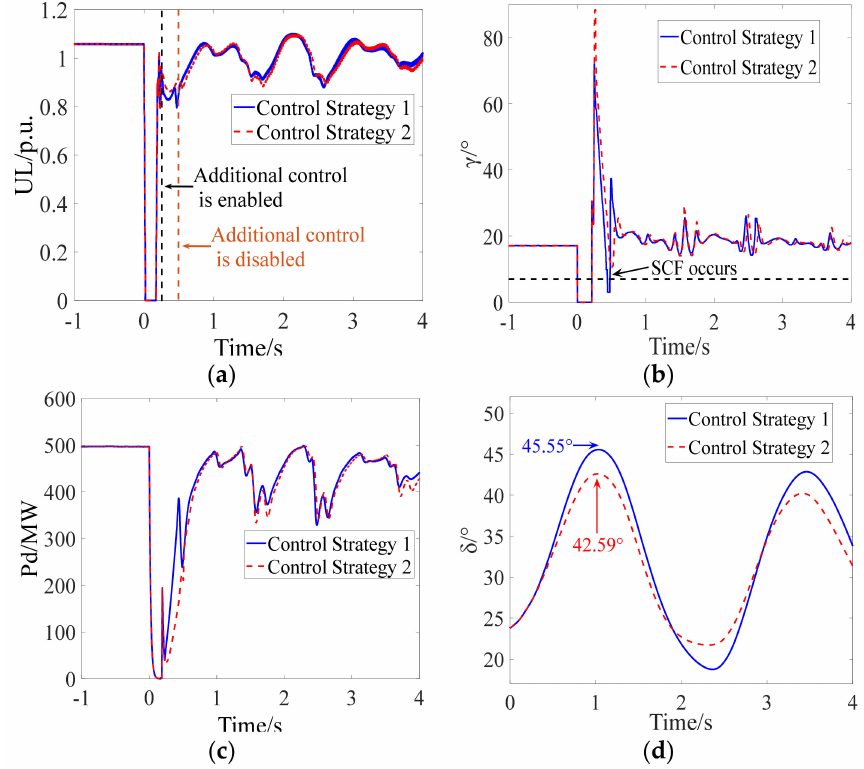
Figure 15. Simulation results of Scenario 1. ( a ) Inverter bus voltage, ( b ) extinction angle, ( c ) DC power, ( d ) relative rotor angle.